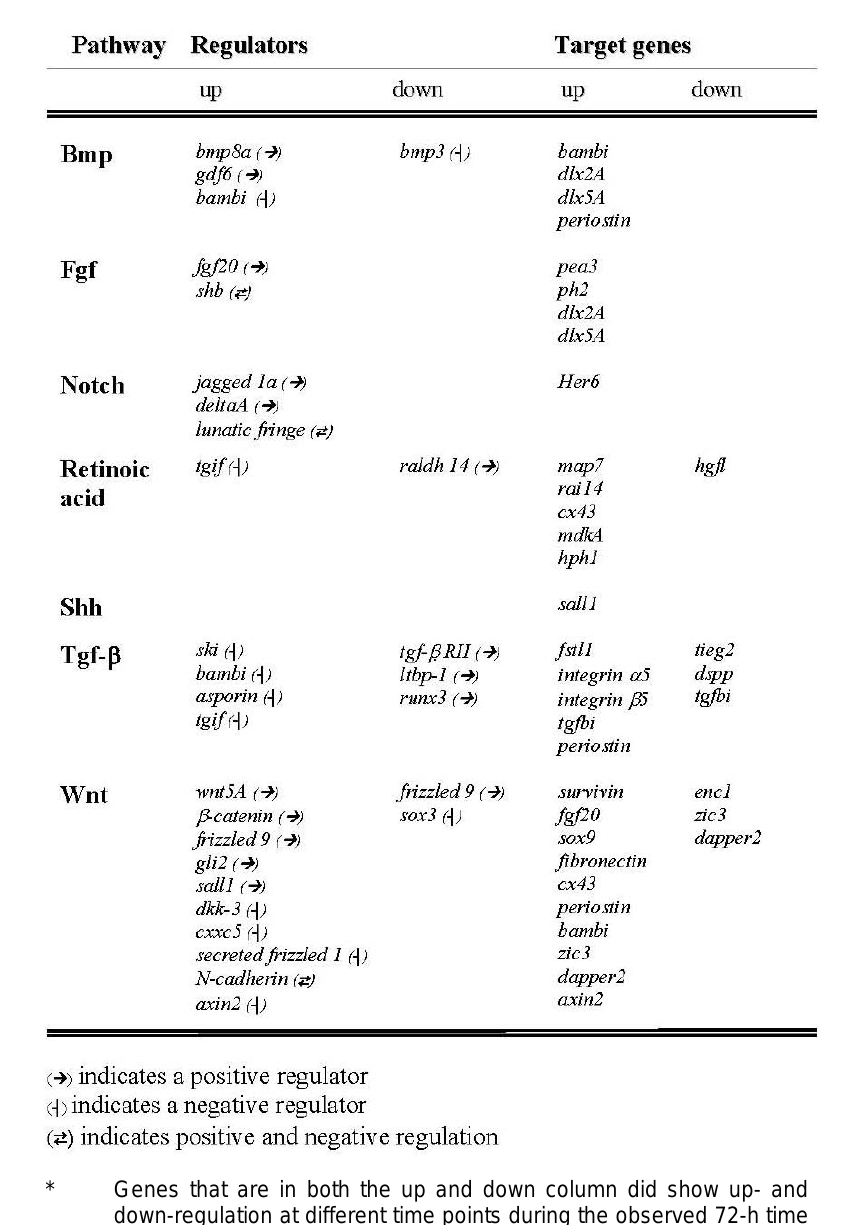
Summery of Signaling Molecules Differentially Expressed During Fin